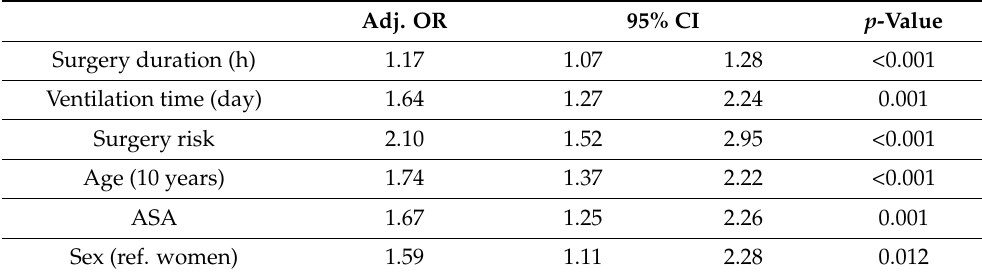
Table 4. Multiple logistic regression analysis (POD vs. non-POD group). Adj. OR 95% CI p